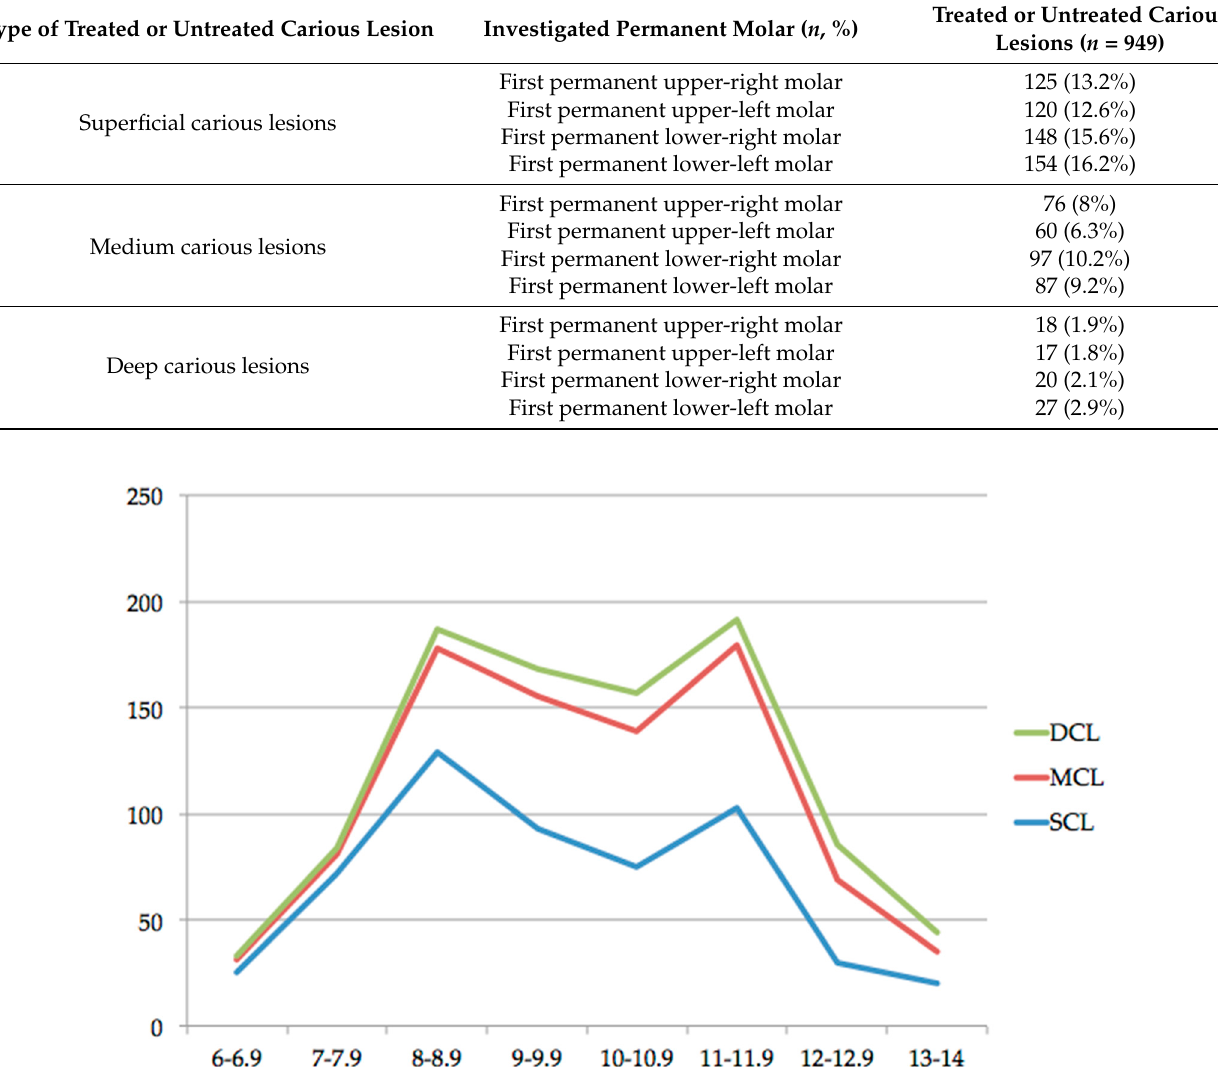
Figure 5. Distribution of superficial carious lesions (SCL), medium carious lesions (MCL), and deep carious lesions (DCL) according to the dental age of the patients (expressed in years). The comparison between the number of superficial, medium, and deep carious lesions related to the gender of the patients showed that the distribution of the number of carious lesions was non-parametric in all three types of carious lesions for both genders. According to the Mann–Whitney U test, the differences were not statistically